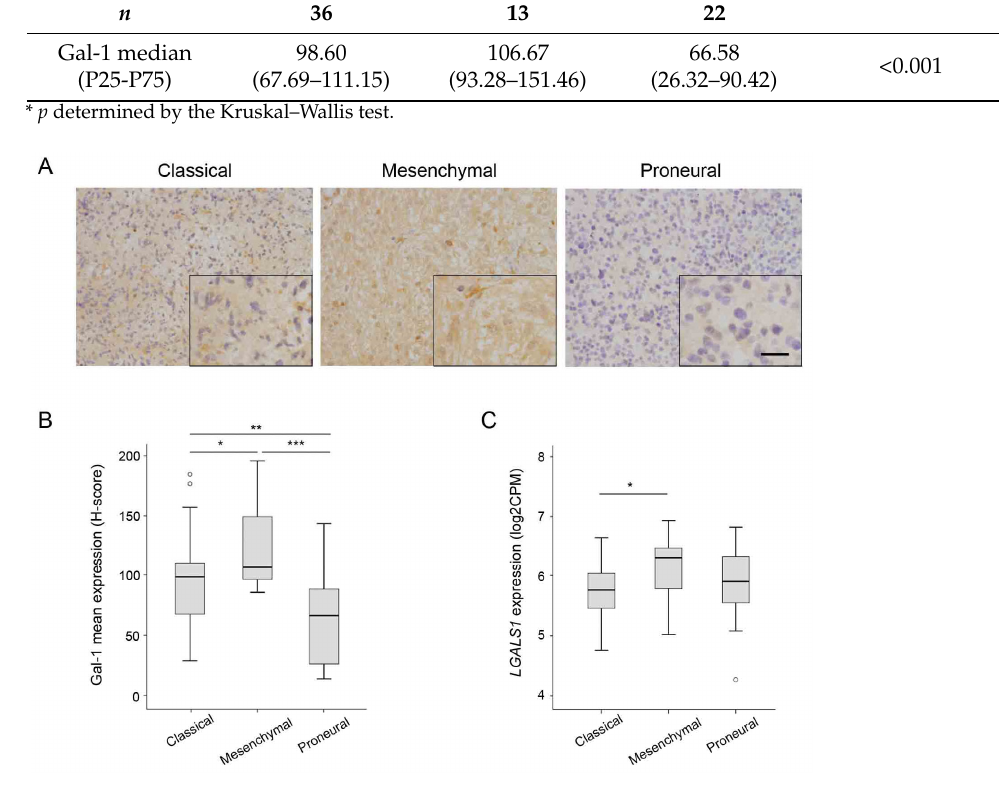
7 of 16 Figure 3. Correlation between mean Gal ‐ 1 expression and Karnofsky Performance Scale (KPS) ( a ), MGMT promoter methylation ( b ), or IDH ‐ 1 status ( c ). *** p (Mann ‐ Whitney U test) < 0.001. 3.3. Correlation between Gal ‐ 1 and GBM Molecular Subtypes Recent advances in genomic studies have allowed a novel classification and grading of GBM based on more accurate transcriptional biomarkers. This has resulted in the GBM molecular subgroup classification, paving the way to precision medicine. Tumors in ‐ cluded in the GLIOCAT multicenter study were analyzed by RNA ‐ seq and classified into